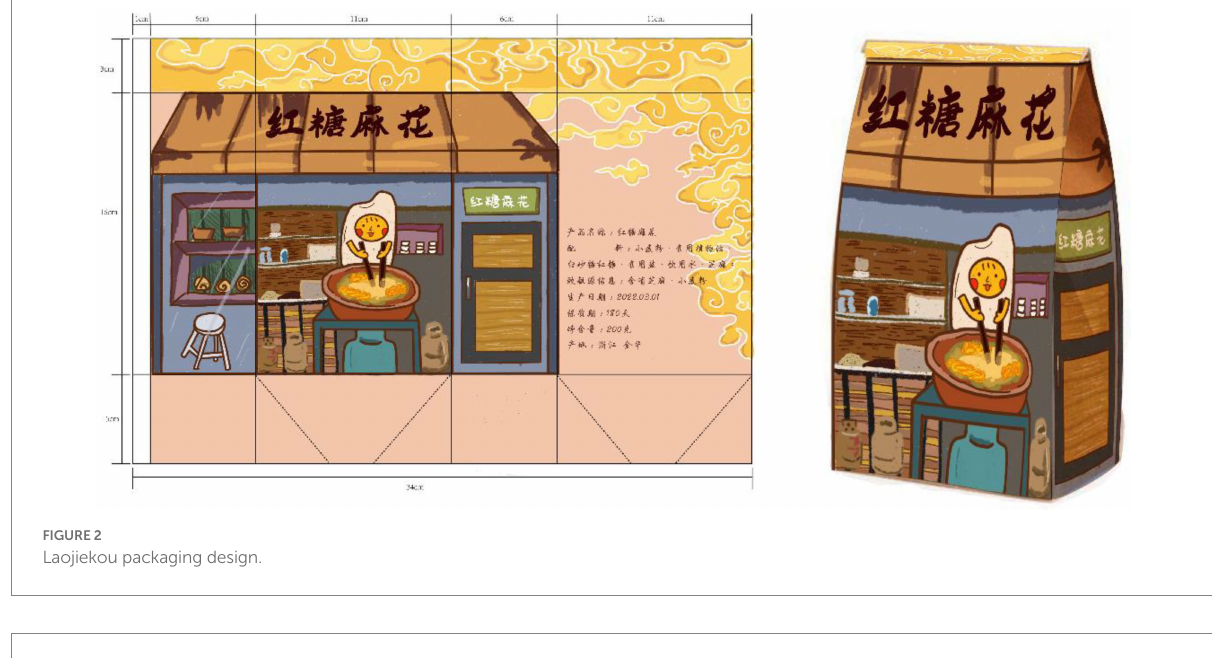
FIGURE 2 Laojiekou packaging design.